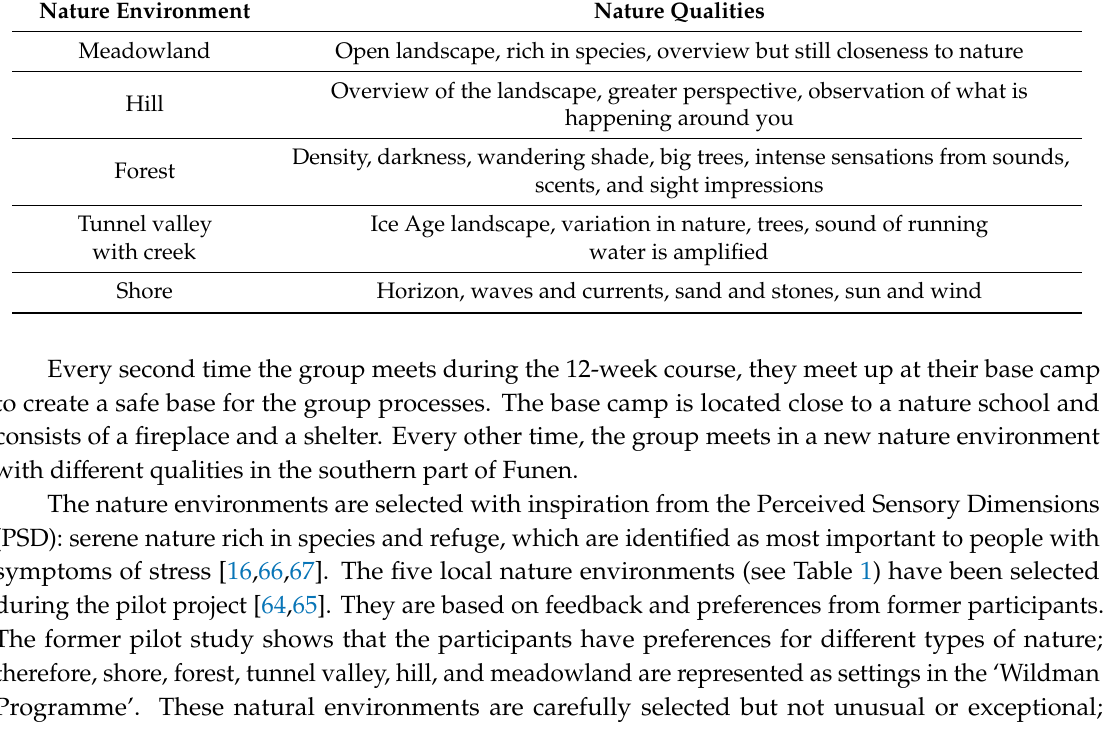
Table 1. The nature qualities of the five nature environments in the ‘Wildman Programme’. Nature